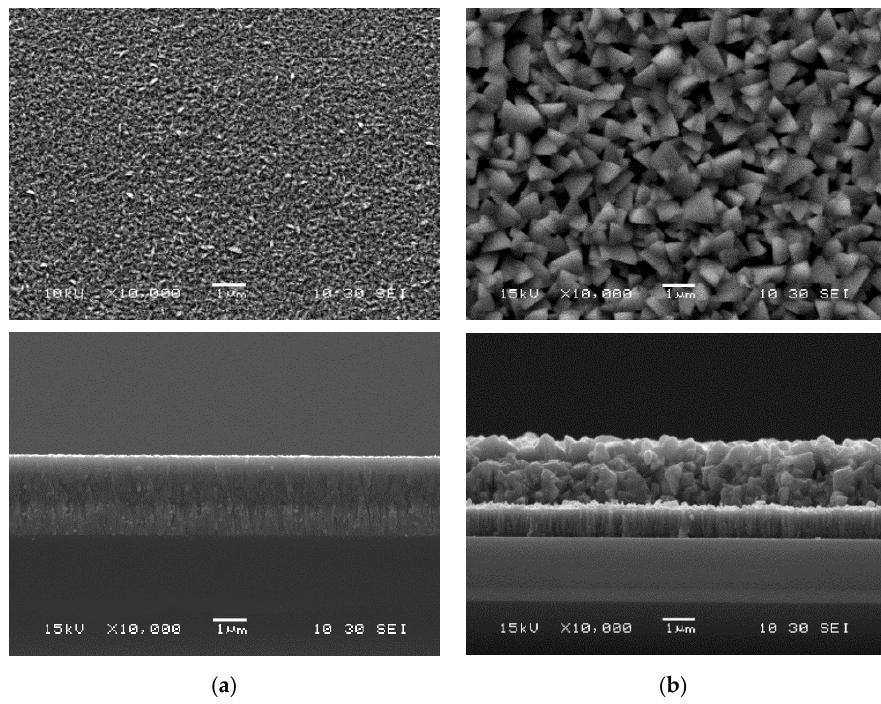
Figure 1. Scanning electron microscopy micrographs (surface and cross section) of CIGS films: as-deposited ( a ) and recrystallized in InBr 3 at 400 °C ( b ).